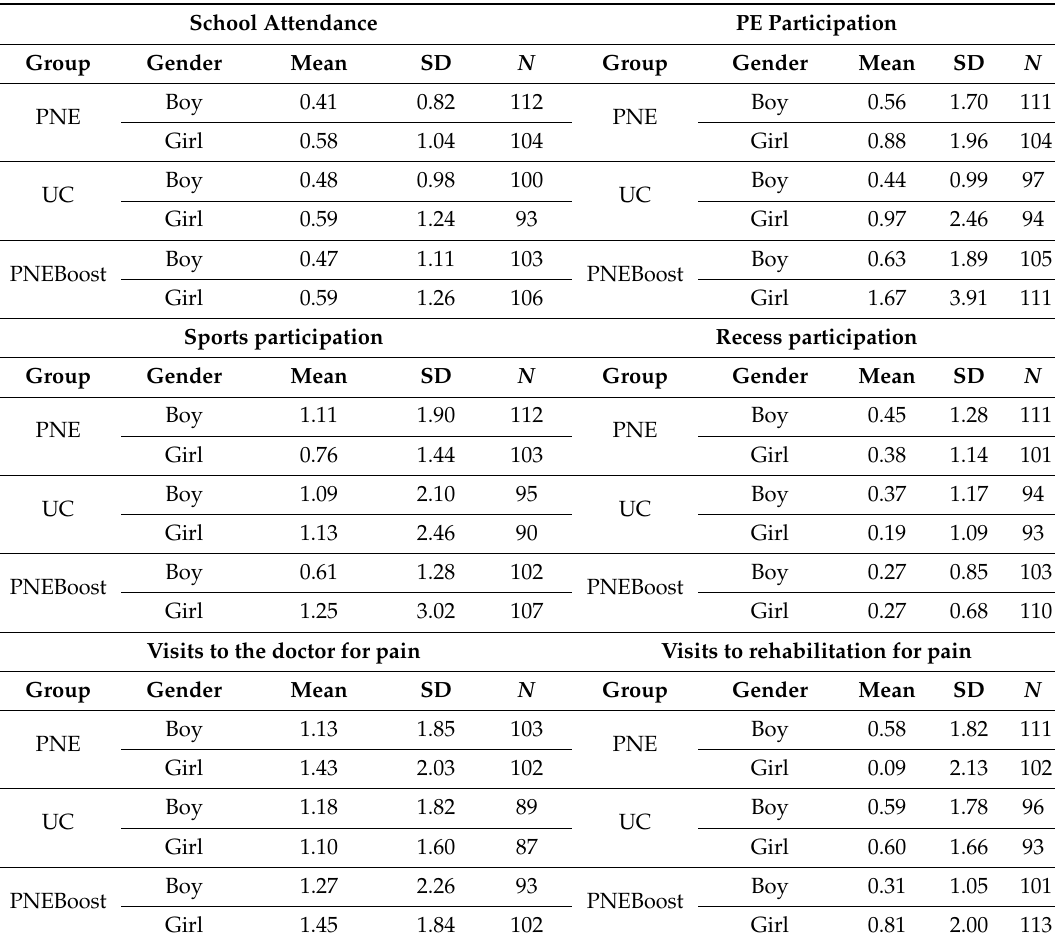
Table A1. Descriptive statistics for Aim